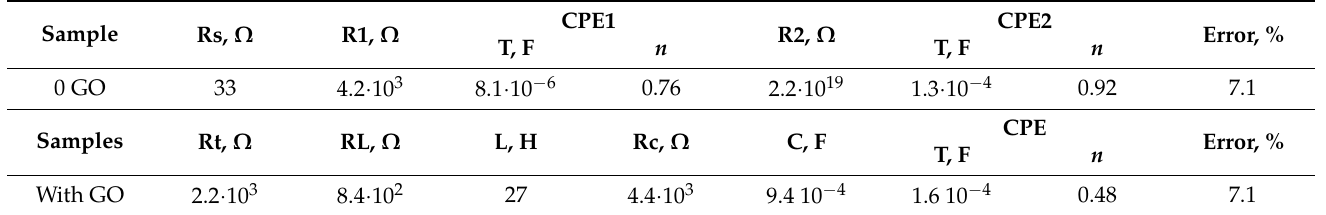
Table 5. The value of the parameters of equivalent circuit elements for samples with MAO coatings formed on titanium alloy in electrolytes without (0 GO) and with (With GO) graphene oxide